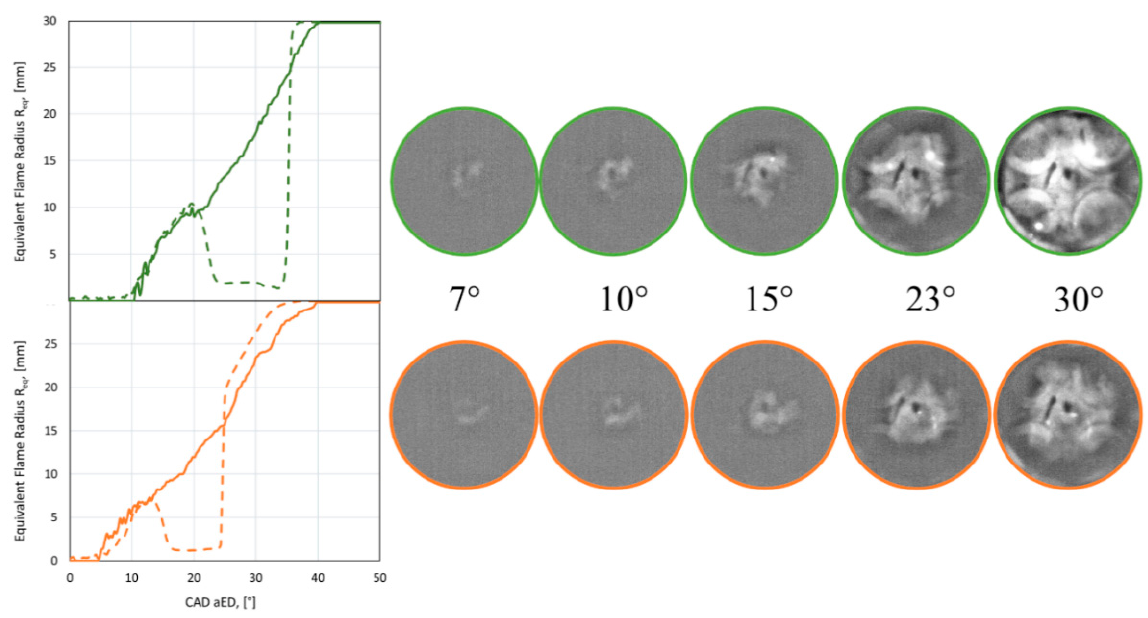
Figure 11. Evaluation of the flame front in order to evaluate the actual existence of the combustion detected as an anomaly by the BR code.